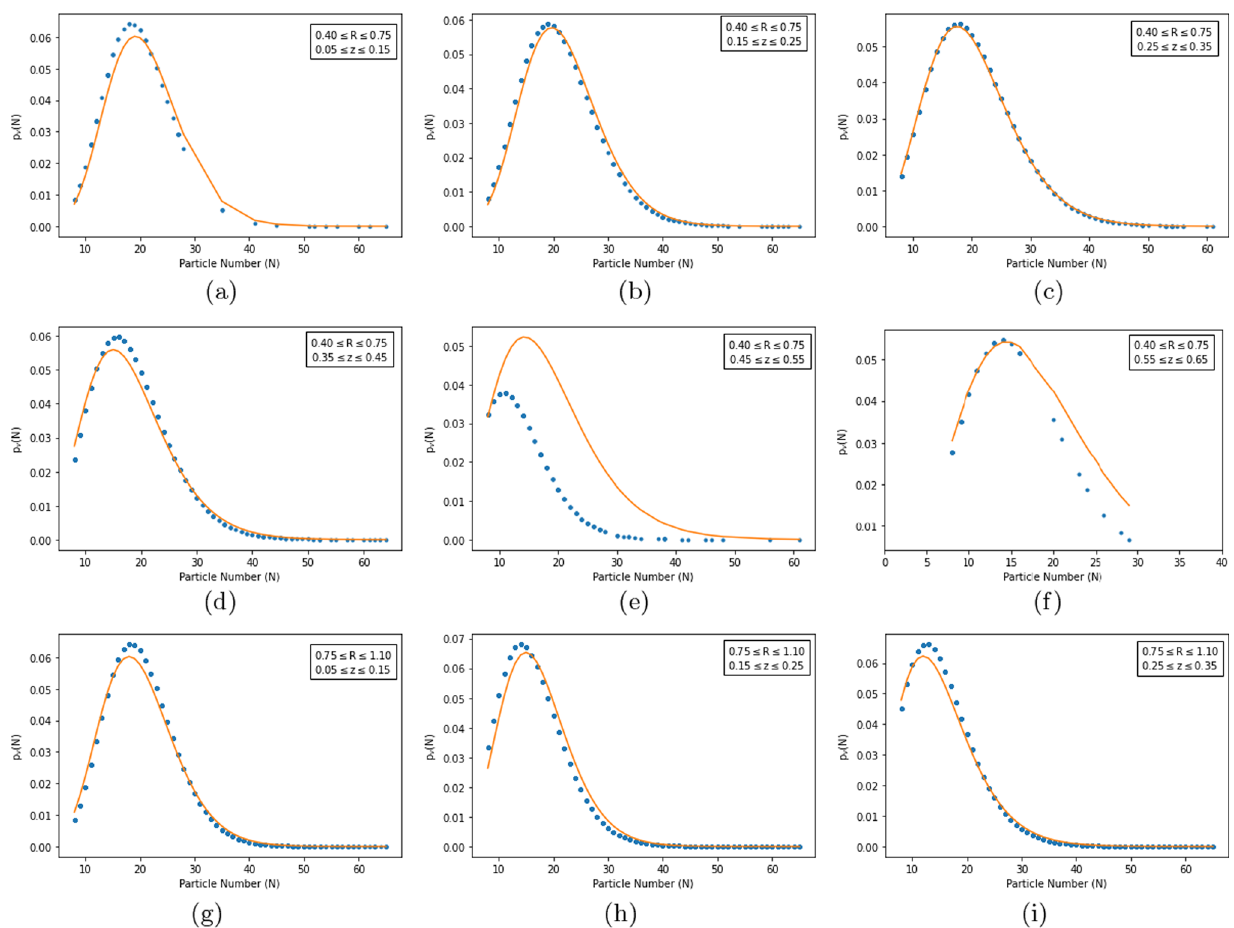
Fig. 3 The plots show the probability distribution function of galaxy clusters in red-shift bins and radius bins. The dotted lines represent the observational data points whereas the solid lines represent the theoretical model considered